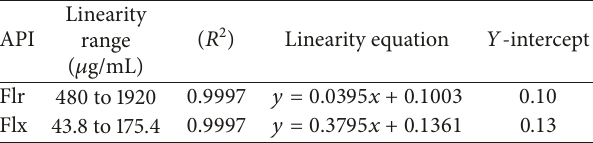
Table 4: Regression analysis of florfenicol and flunixin.